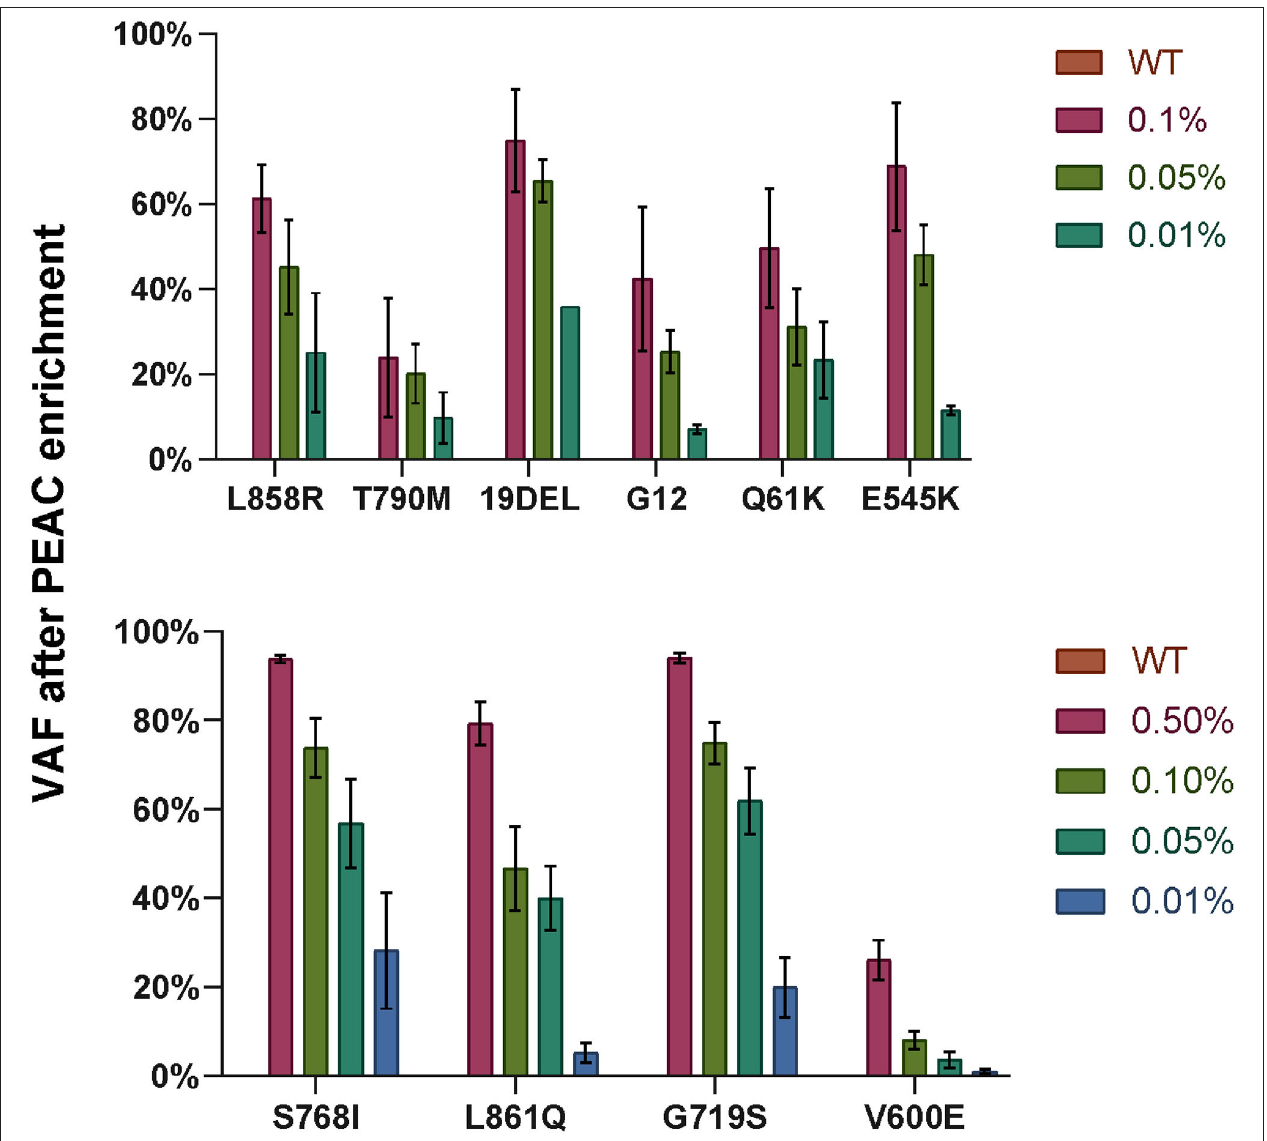
FIGURE 6 | The variant allele fractions (VAFs) of the mutations detected by NGS after PEAC enrichment on cfDNA standards at different allele fractions. Ten enrichment reactions were grouped into two PCR reactions, top part showed EGFR L858R, EGFR T790M, EGFR 19DEL, KRAS G12, NRAS Q61K, and PIK3CA E545K, and bottom part included EGFR S768I, EGFR L861Q, EGFR G719S, and BRAF V600E. The bar heights represent the VAF detected by NGS after PEAC